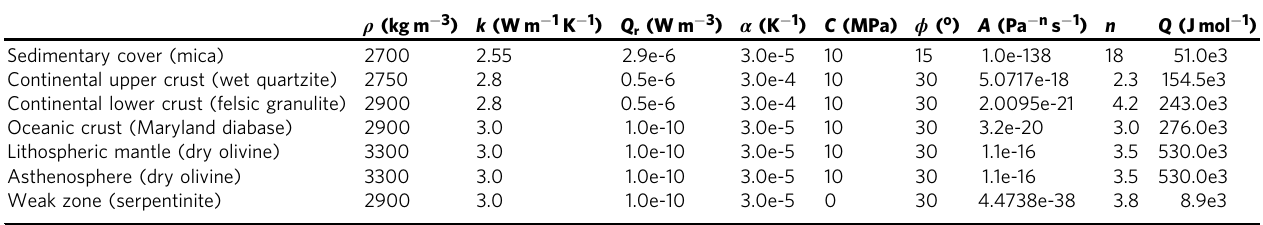
Table 2 Thermal and rheological parameters used for different compositions in the Mod 1 model